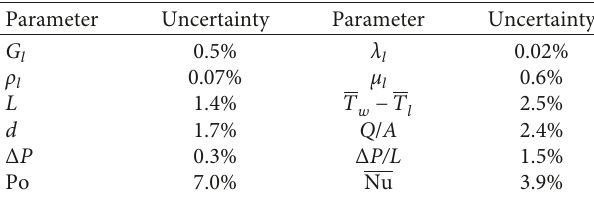
Table 2: List of experimental errors.